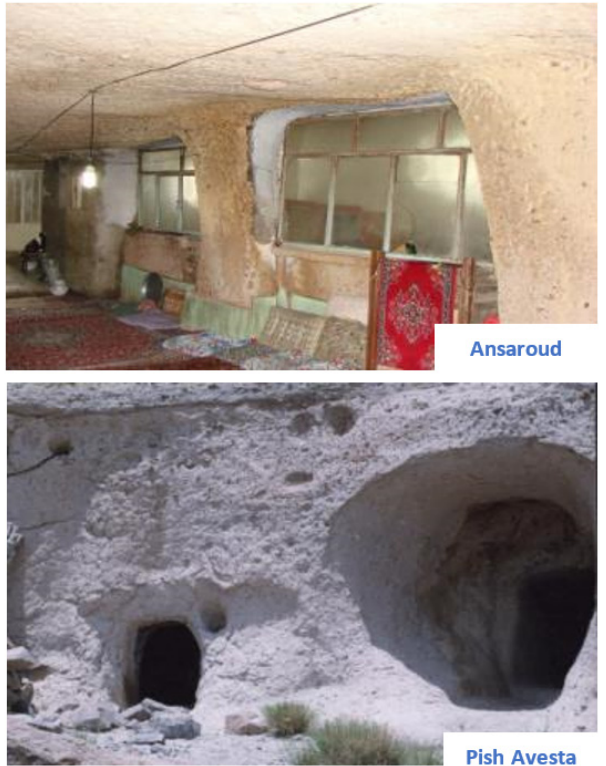
Figure 15. Difference in the size of the particles led to difference in the quality of excavation in Ansaroud Grand Mosque and Pish Avesta Temple.